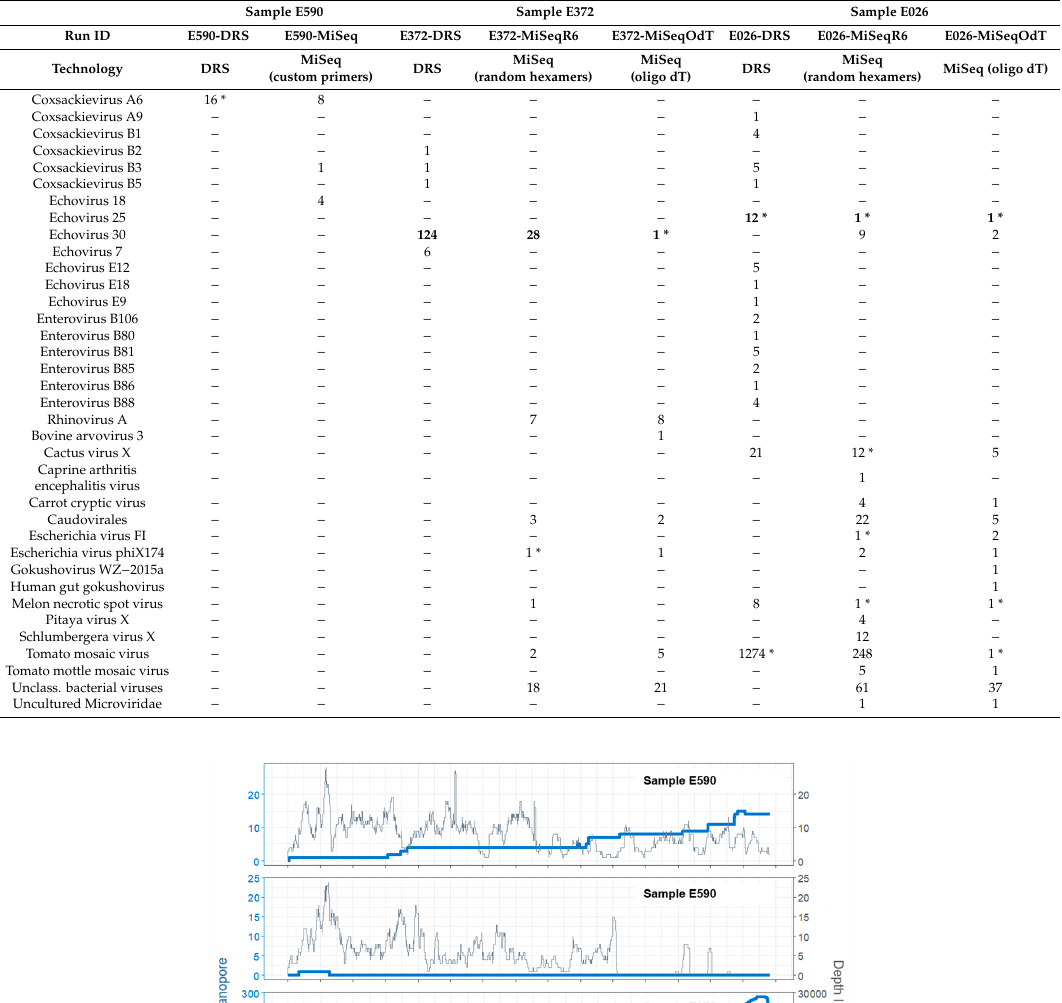
Table 2. Taxonomic classification of viral reads (Oxford Nanopore) and contigs (Illumina MiSeq) using MEGAN based on BLASTN matches against the NCBI’s nucleotide ( nt ) database at the species and genotype levels. Asterisks (*) indicate that > 90% of the respective genome sequence was covered, while bold numbers indicate EV species identity confirmed by Sanger sequencing of the VP1 gene. Minus sign ( − ) indicates absence of hits in the dataset.